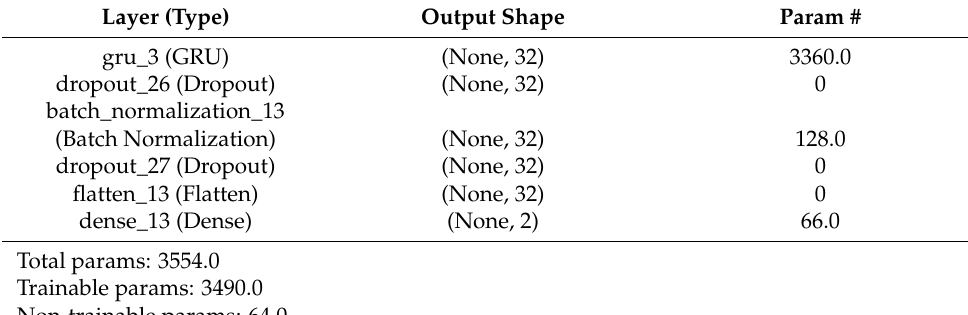
Table 8. Architecture GRU.